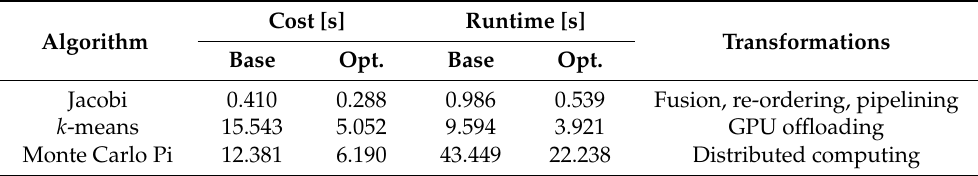
Table 1. The estimated costs and the median measured runtime in seconds for the baseline version (base) and the optimized version